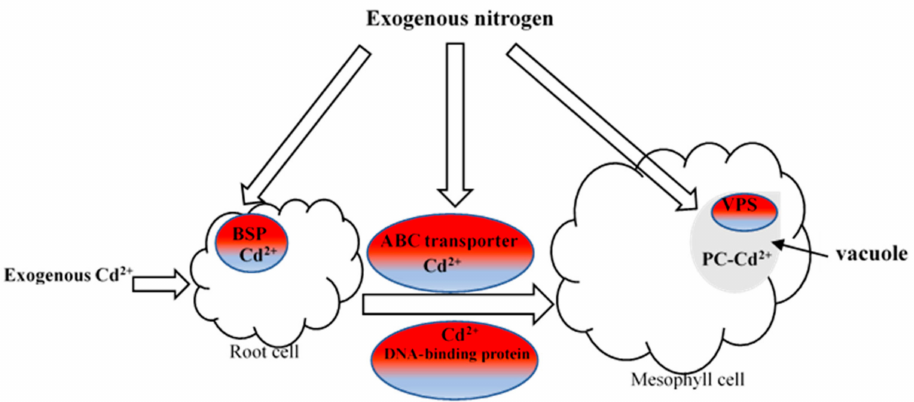
Figure 5. Exogenous nitrogen enhanced the uptake, transport and accumulation of cadmium in poplar plants by up-regulated the expressions of proteins. BSP, bark storage protein; VPS, vacuolar protein sorting-associated protein. Red, up-regulated